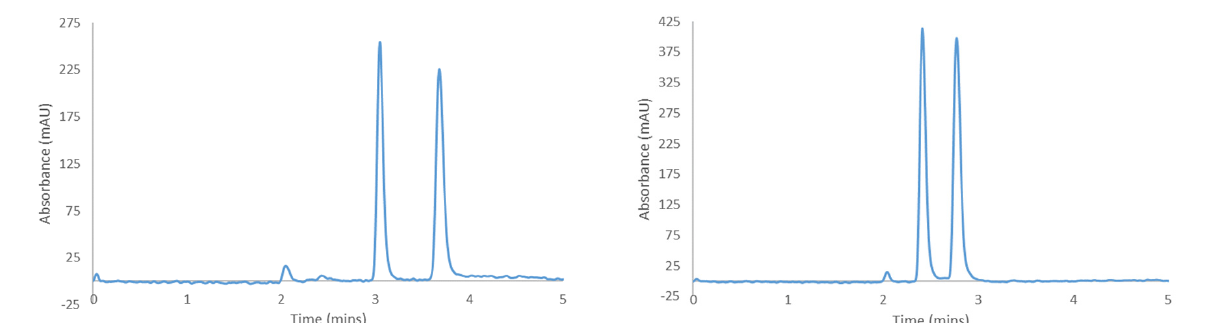
Figure 3. Separation of cannabichromene ( A ) and cannabicyclol ( B ) on CHIRALPAK ® IK ‐ 3 with Hex − DCM = 80 − 20 ( v / v ).